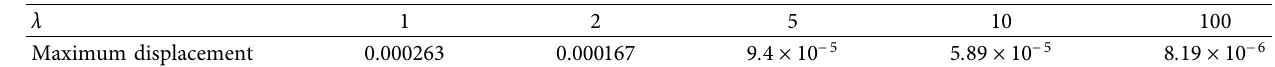
Figure 9: Controlled system behavior for different magnitudes of λ and η � 10. (a) λ � 1, (b). λ � 5, (c). λ � 10, and (d). λ � 100 Table 4: Maximum displacement versus λ .